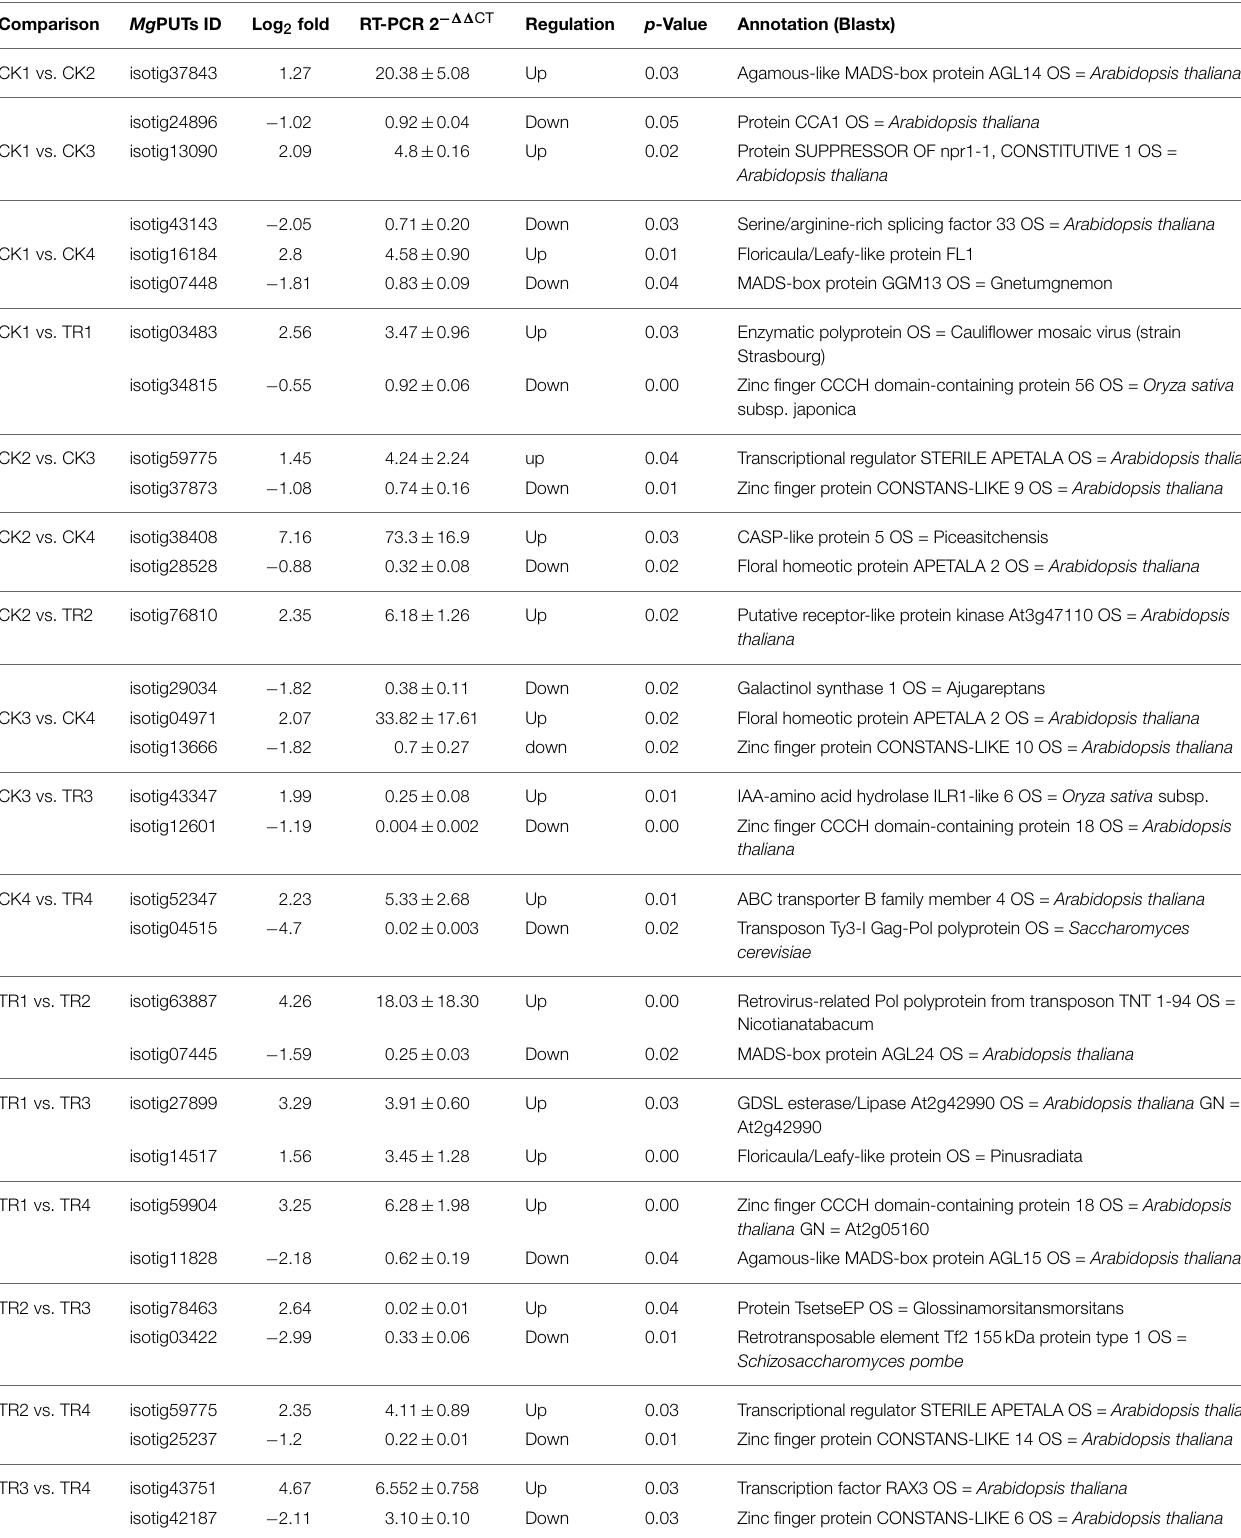
TABLE 6 | Selected DE genes tested with RT-PCR. Comparison